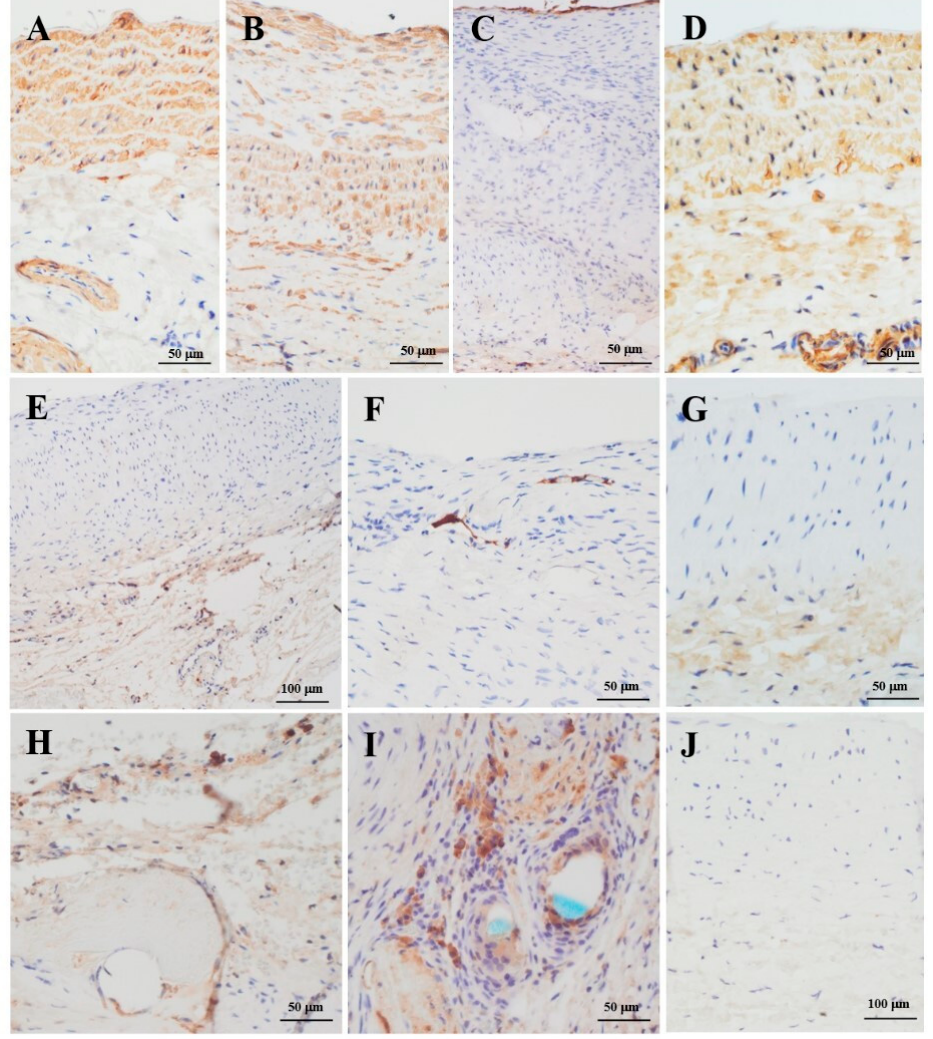
Figure 7. Detail of the abdominal aorta ( A ) and the graft wall ( B , C , E , F , H , I ) of the same section shown in Figure 5D, and SOG aorta ( D , G , J ). ( B ) In the tunica media of the PAG, the 70% of cells